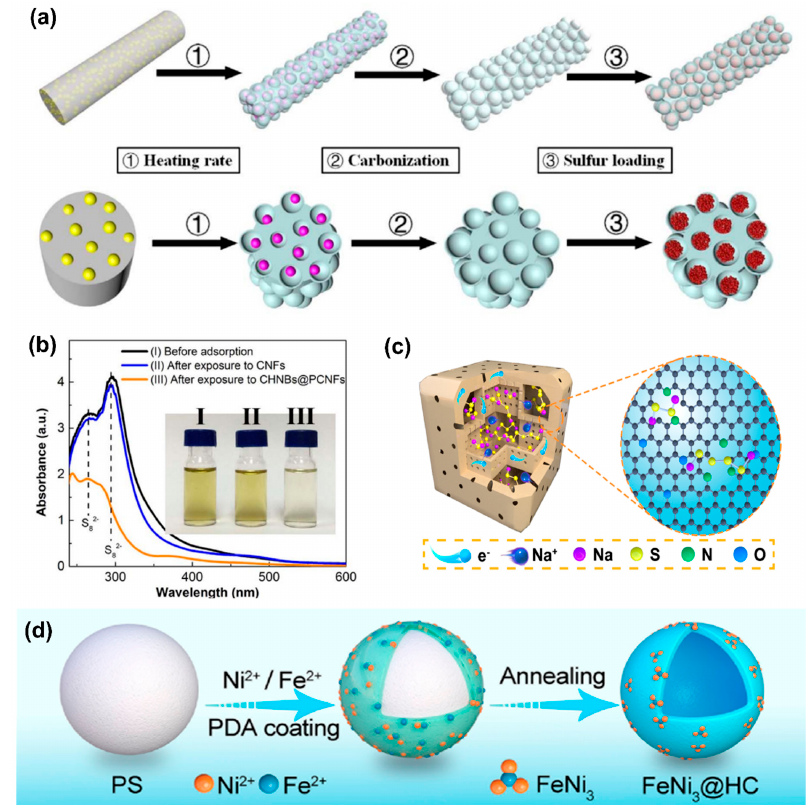
Figure 4. ( a ) Carbon hollow nanobubbles on porous carbon fi bers as S hosts, and ( b ) the demonstra- tion of PS adsorption capability via UV spectroscopy. Reproduced with permission [58]. Copyright